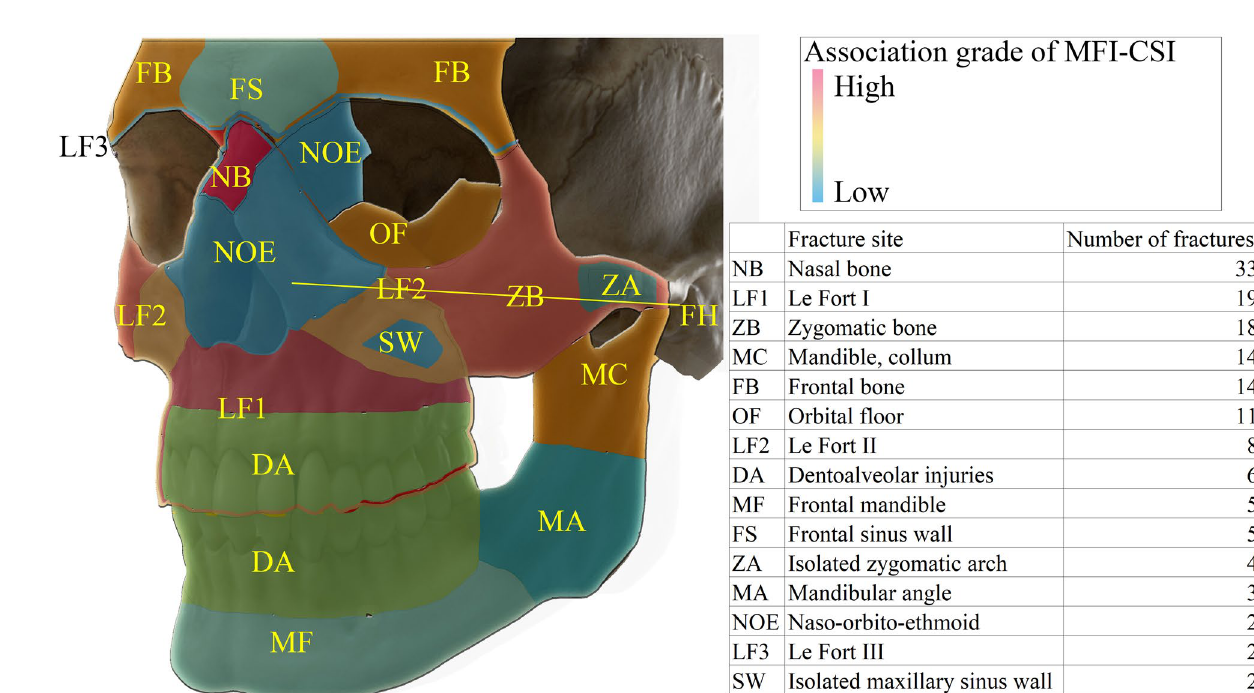
Figure 5. Heat map showing the areas of the skull with a higher risk of CSI. Fractures of the forehead, the nose, Le Fort I and II-level, zygomatic complex and the mandibular condyle are more often associated with CSI. The table includes the total number of fracture sites in MFI–CSI patients and thus does not refer to the number of patients. The yellow line represents the Frankfurt horizontal line on the left